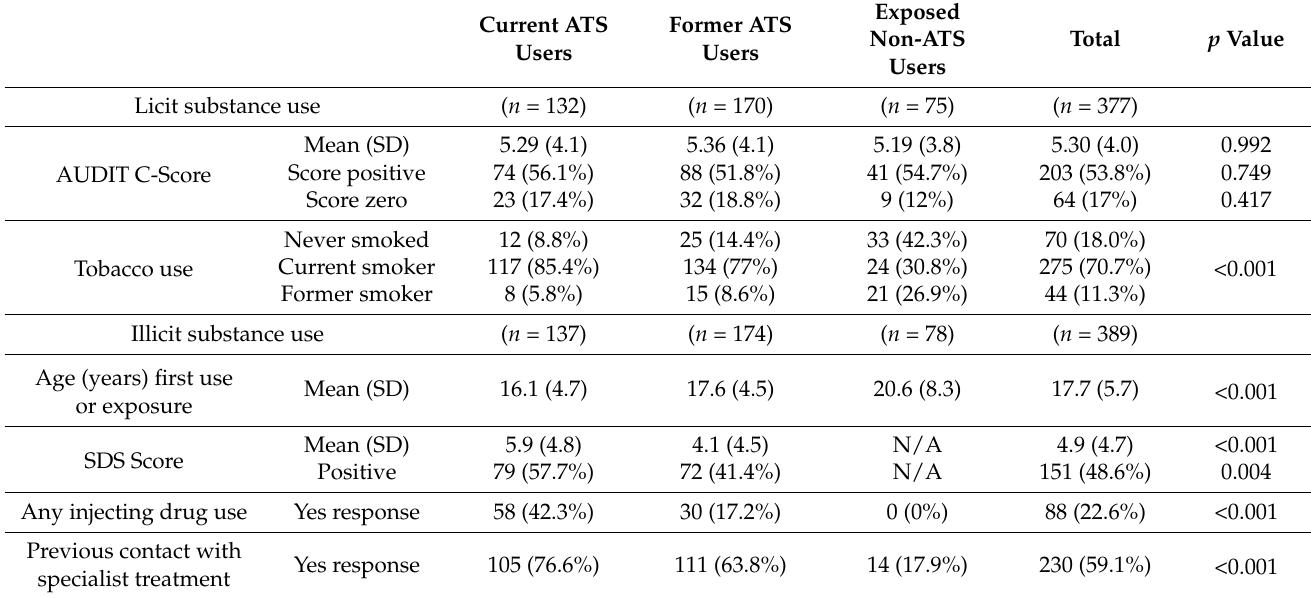
Table 2. Differences in means and prevalence of licit and illicit substance use by study groups 1